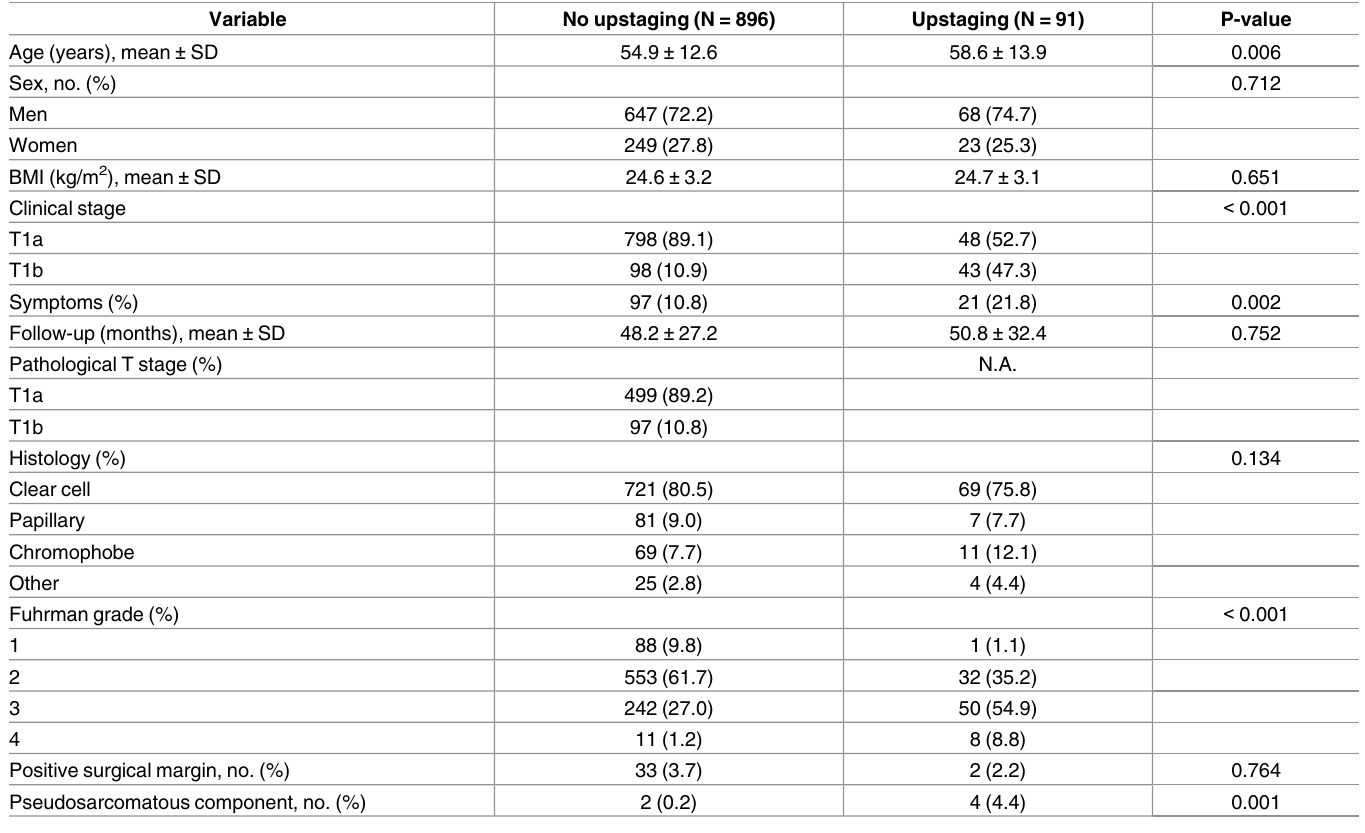
Table 1. Clinical and pathological